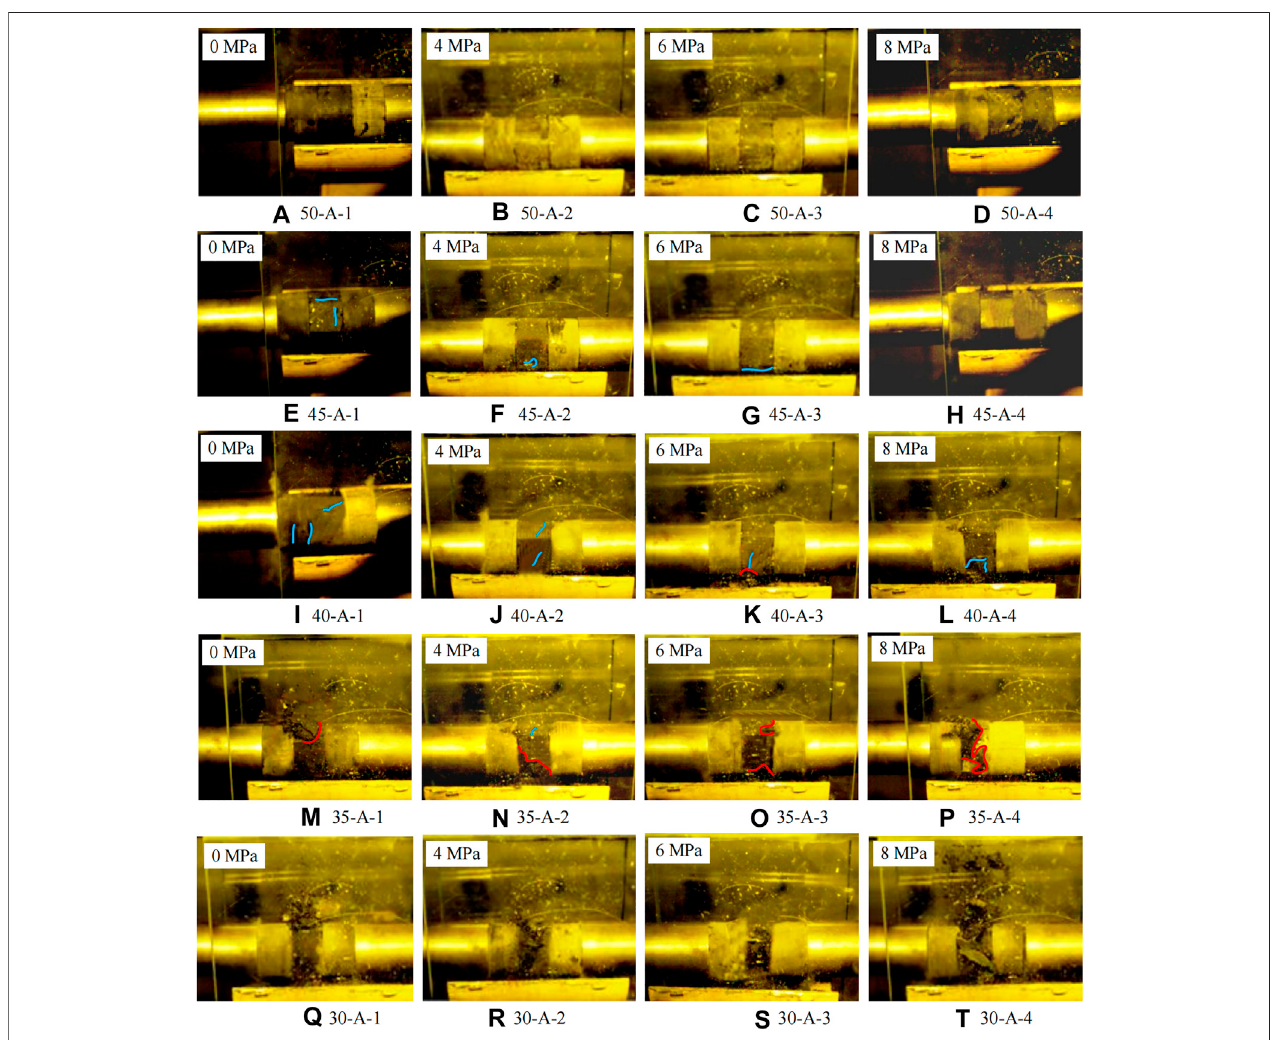
FIGURE 7 | (A – T) Failure patterns of specimens under different pre-static loads at the maximum strike velocity.